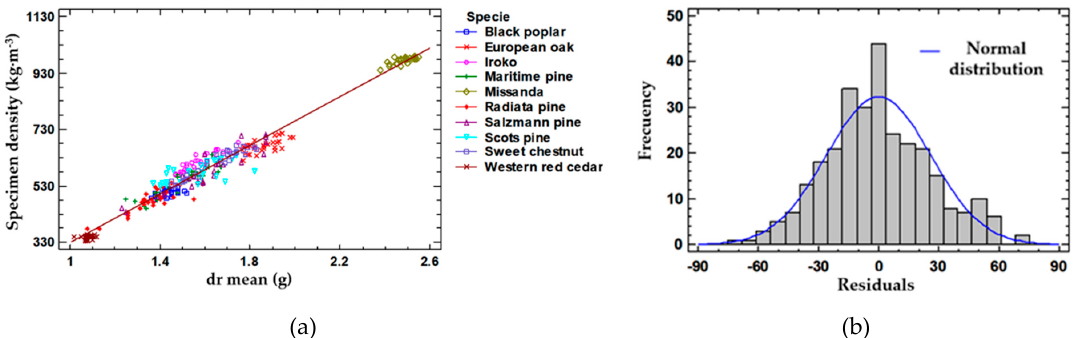
Figure 6. Linear regression between specimen density and drill residue mass mean of radial and tangential results. ( a ) Plot of the fitted model; ( b ) Frequency histogram of the model residuals.